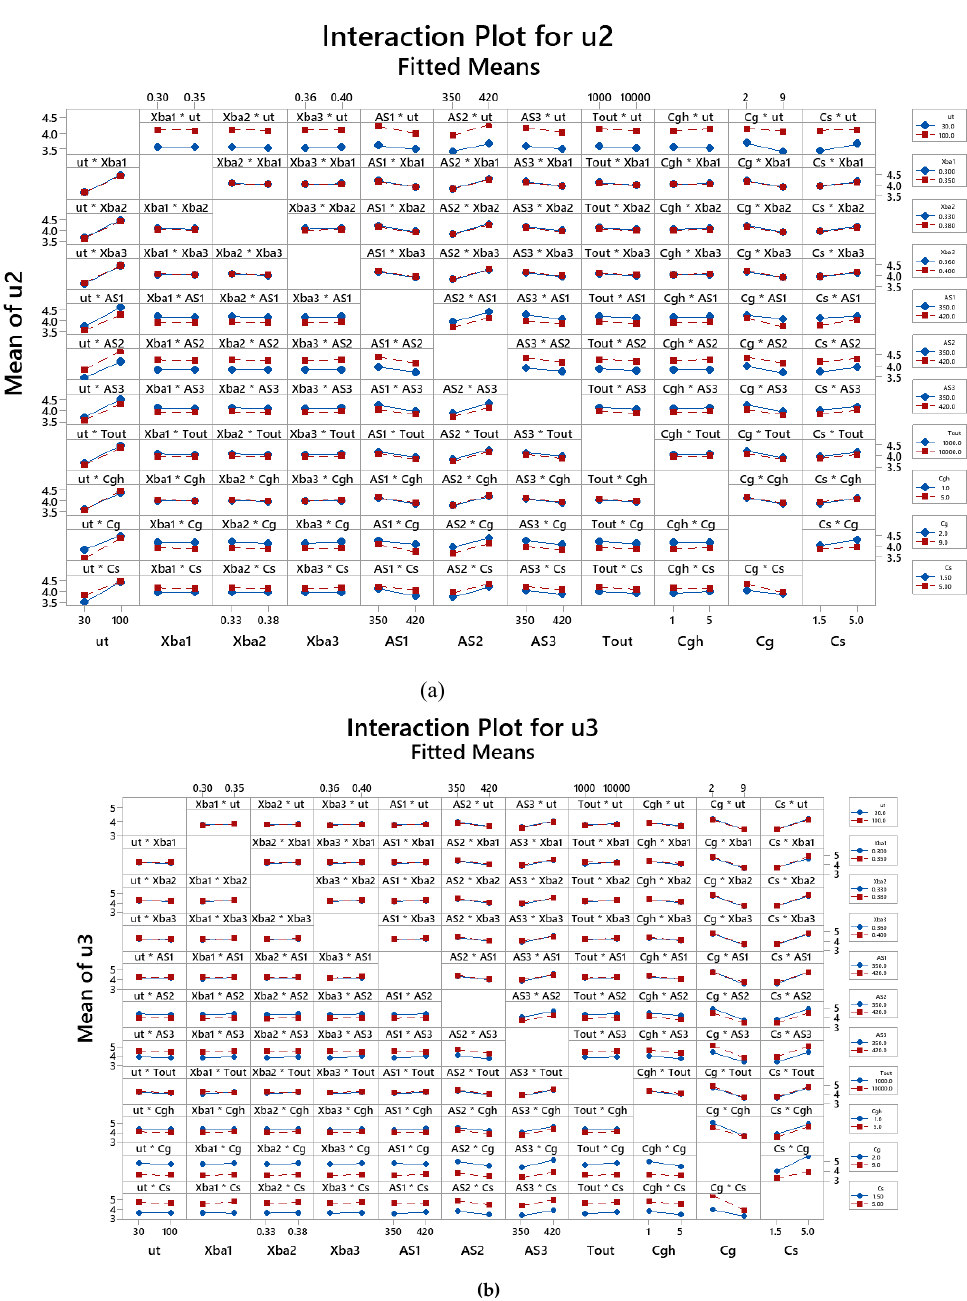
Figure 5. The interactions between input parameters on the response of 𝑢 (cid:2870) ( a ) and 𝑢 (cid:2871) ( b ).